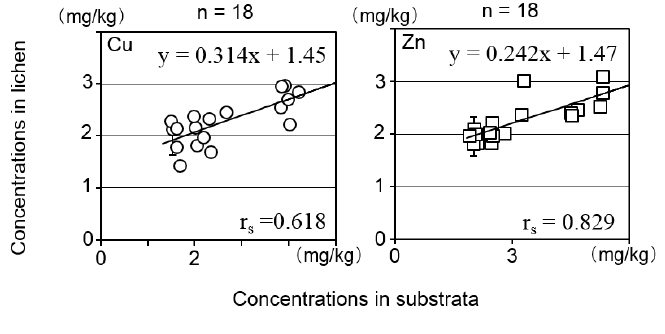
Figure 10. Scatter diagrams show Cu and Zn concentration of S . exutum and the corresponding substrata with linear functions after logarithmic transformation. Note: significance level = 5%. n = sample